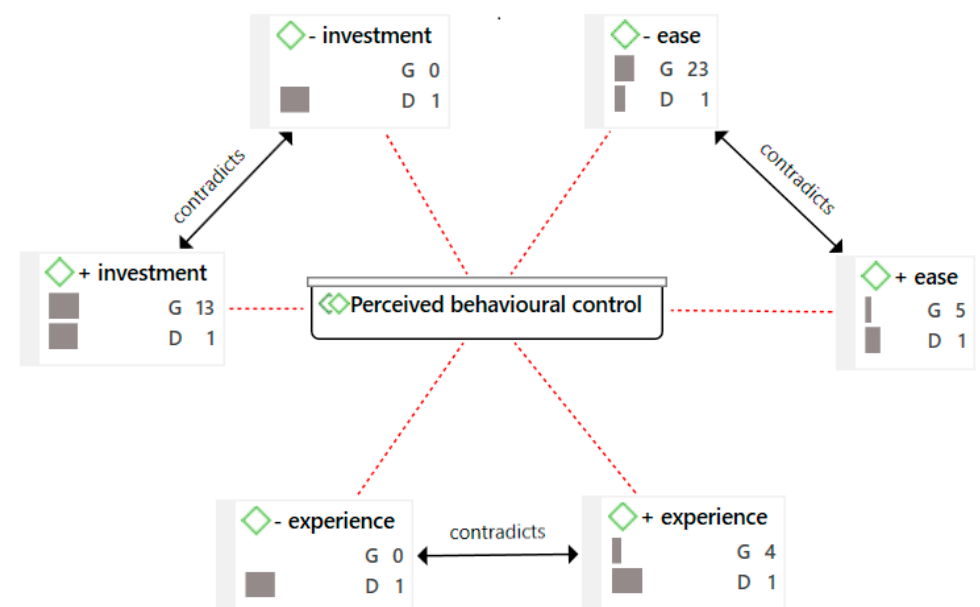
Figure 4. Participants perceived behavioural control (source: original).